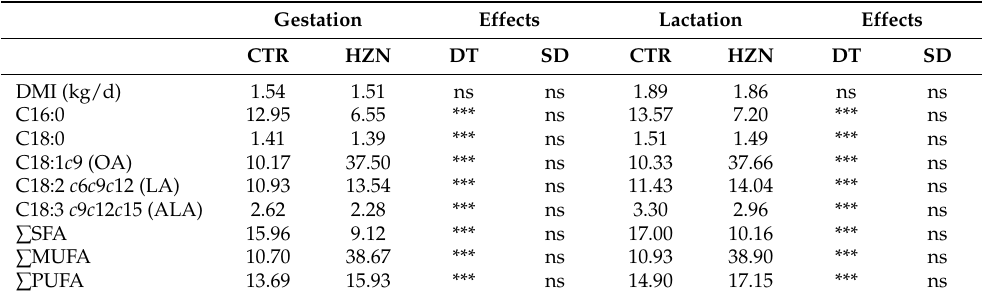
Table 2. Dry matter and main fatty acids intake (g/d) of ewes fed CTR and HZN diets during gestation and lactation